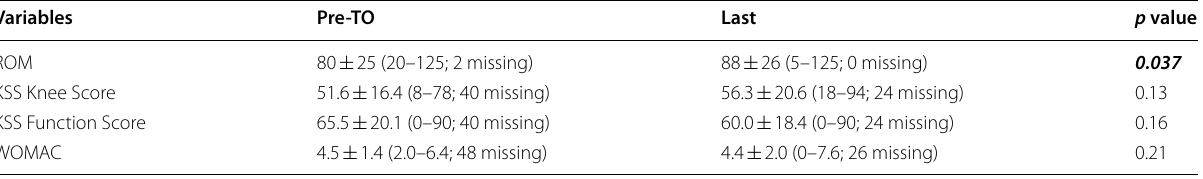
Continuous variables are shown as mean standard deviation (range; number of missing values) ± Significant differences are displayed in bold and italic ROM range of motion, KSS Knee Society Score, pre-TO immediately before tuberositas osteotomy, last final follow-up